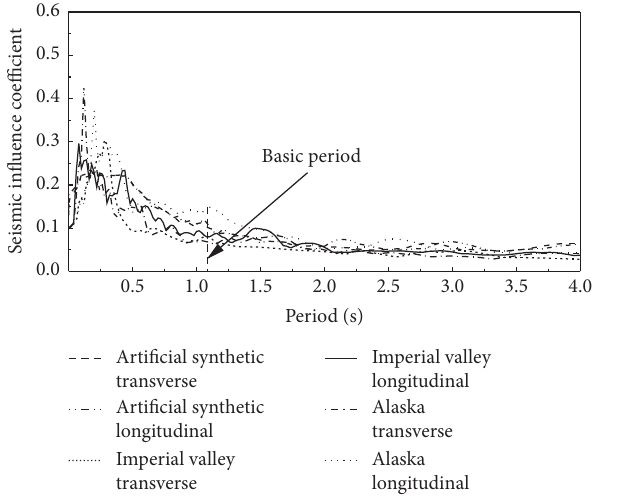
Figure 9: Response spectra of acceleration applied in pseudody- namic experiments.